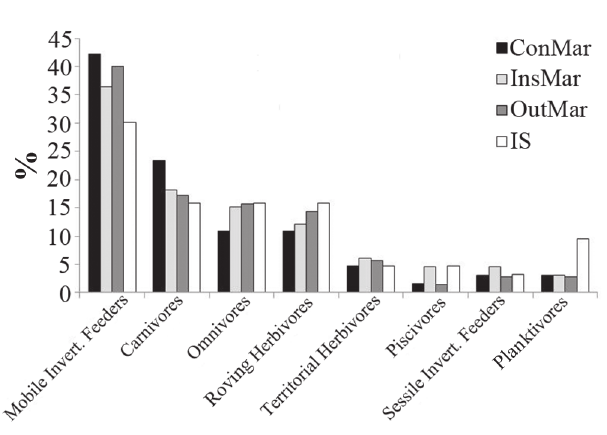
Fig. 2. Contribution (%) of each trophic category in the four strata: Continental Margin (ConMar), Insular Margin (InsMar), Outer Margin (OutMar) and Islands (IS) (see Table (Table 2). Dunn’s post-hoc test with paired comparisons between habitats corroborates the ANOSIM results (Table 2), with significant differences in fish density per sample between bottoms vs . walls or tops, and also between ConMar vs . InsMar, Con Mar vs . IS, InsMar vs . OutMar and OutMar vs . IS (p <0.05). The SIMPER analysis revealed 11-12 species with the highest contribution to within-group similarities at the four strata, with six consistently widespread species (Tables 1 and 3): A. saxatilis ,